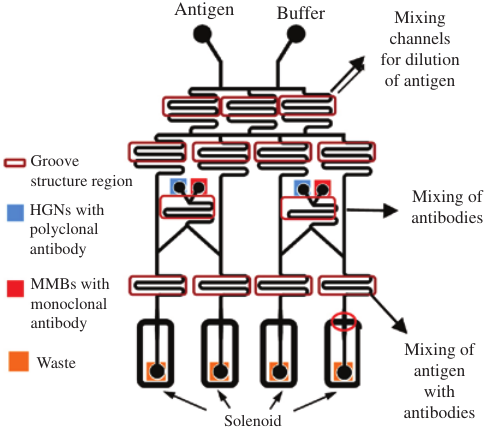
Figure 7: Layout of SERS-based gradient optofluidic sensor integrated with solenoids and various regions of microchannels designed for mixing. Adapted with permission from [181]. Copyright